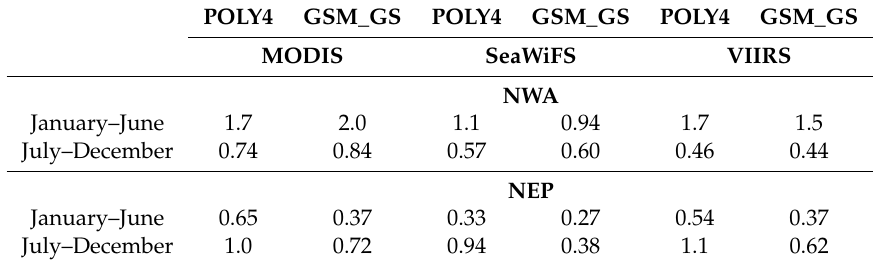
Table A6. Average difference between first and third quartiles presented in the boxplots of Figures 6 and 7 across boxes representing the first half of the year, and across the second half of the year.